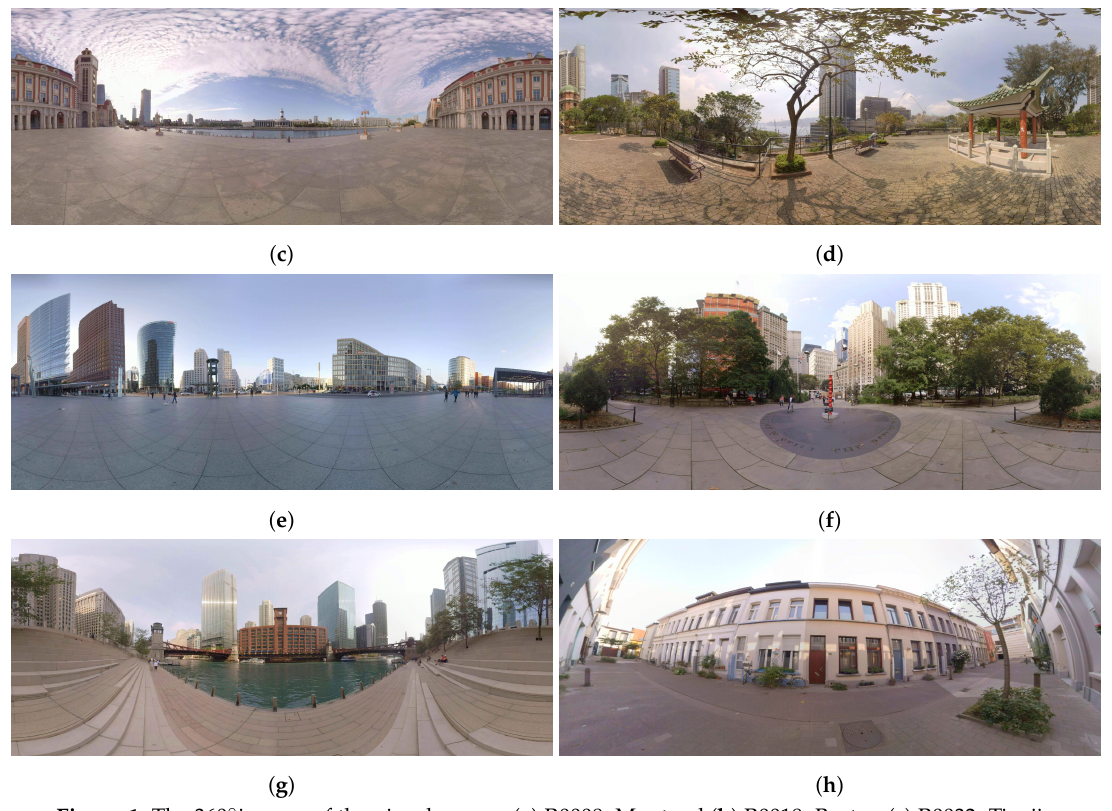
Figure 1. The 360 ◦ images of the visual scenes. ( a ) R0008: Montreal ( b ) R0018: Boston ( c ) R0032: Tianjin ( d ) R0043: Hong eKong ( e ) R0063: Berlin ( f ) R0064: New York ( g ) R0092: Chicago ( h ) AT01: